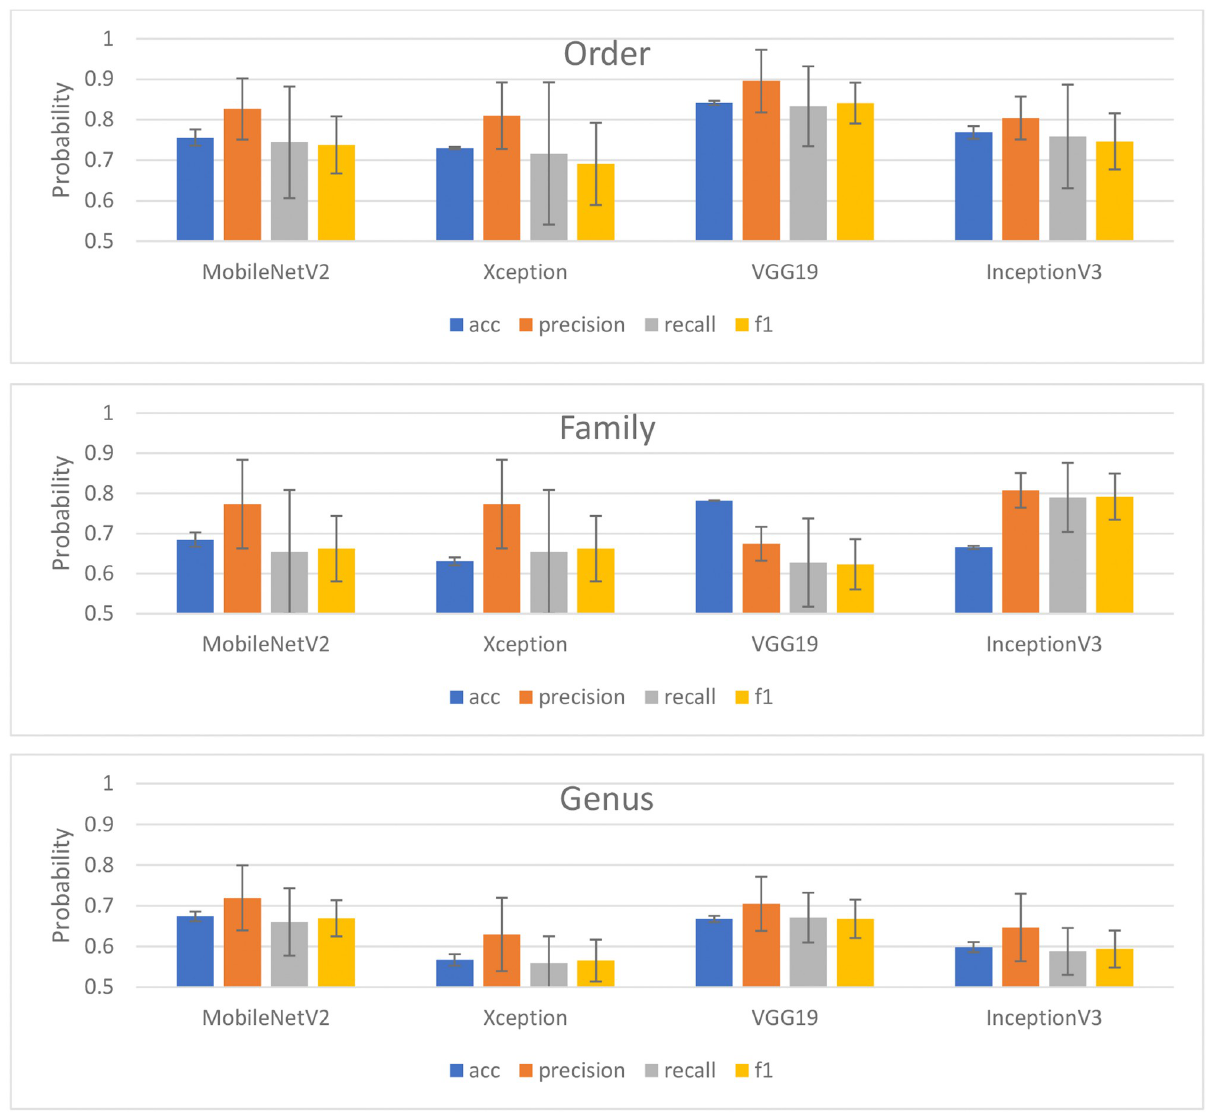
Fig 3. Evaluation matrices of four DL models according to the respective taxonomic